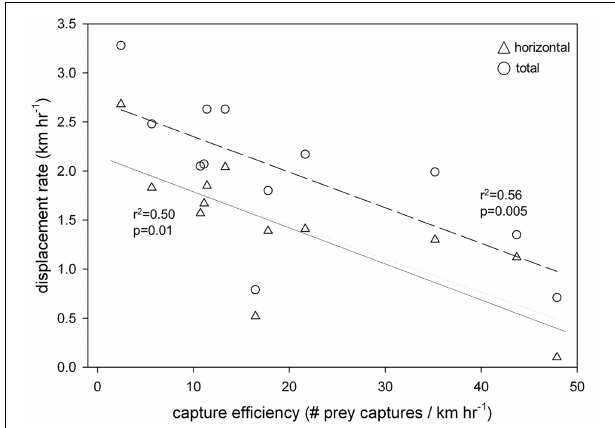
FIGURE 5 | Displacement rate (km h − 1 ) of leatherback turtles ( Dermochelys coriacea ) was inversely related to efficiency of prey capture [number of jellyfish captured per unit search effort (km h − 1 )] in the Northwest Atlantic Ocean off Nova Scotia,